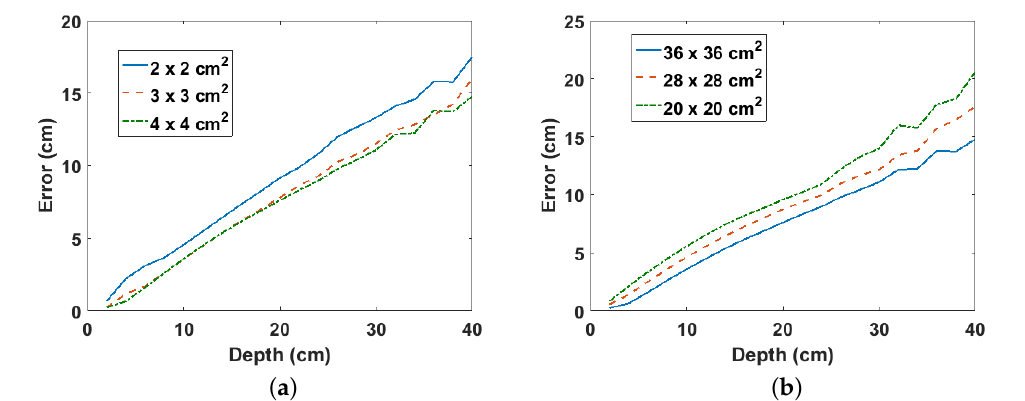
Figure 10. ( a ) Error per depth for different cell sizes for Co-60 buried in sand; ( b ) error per depth for different scan areas for Co-60 buried in